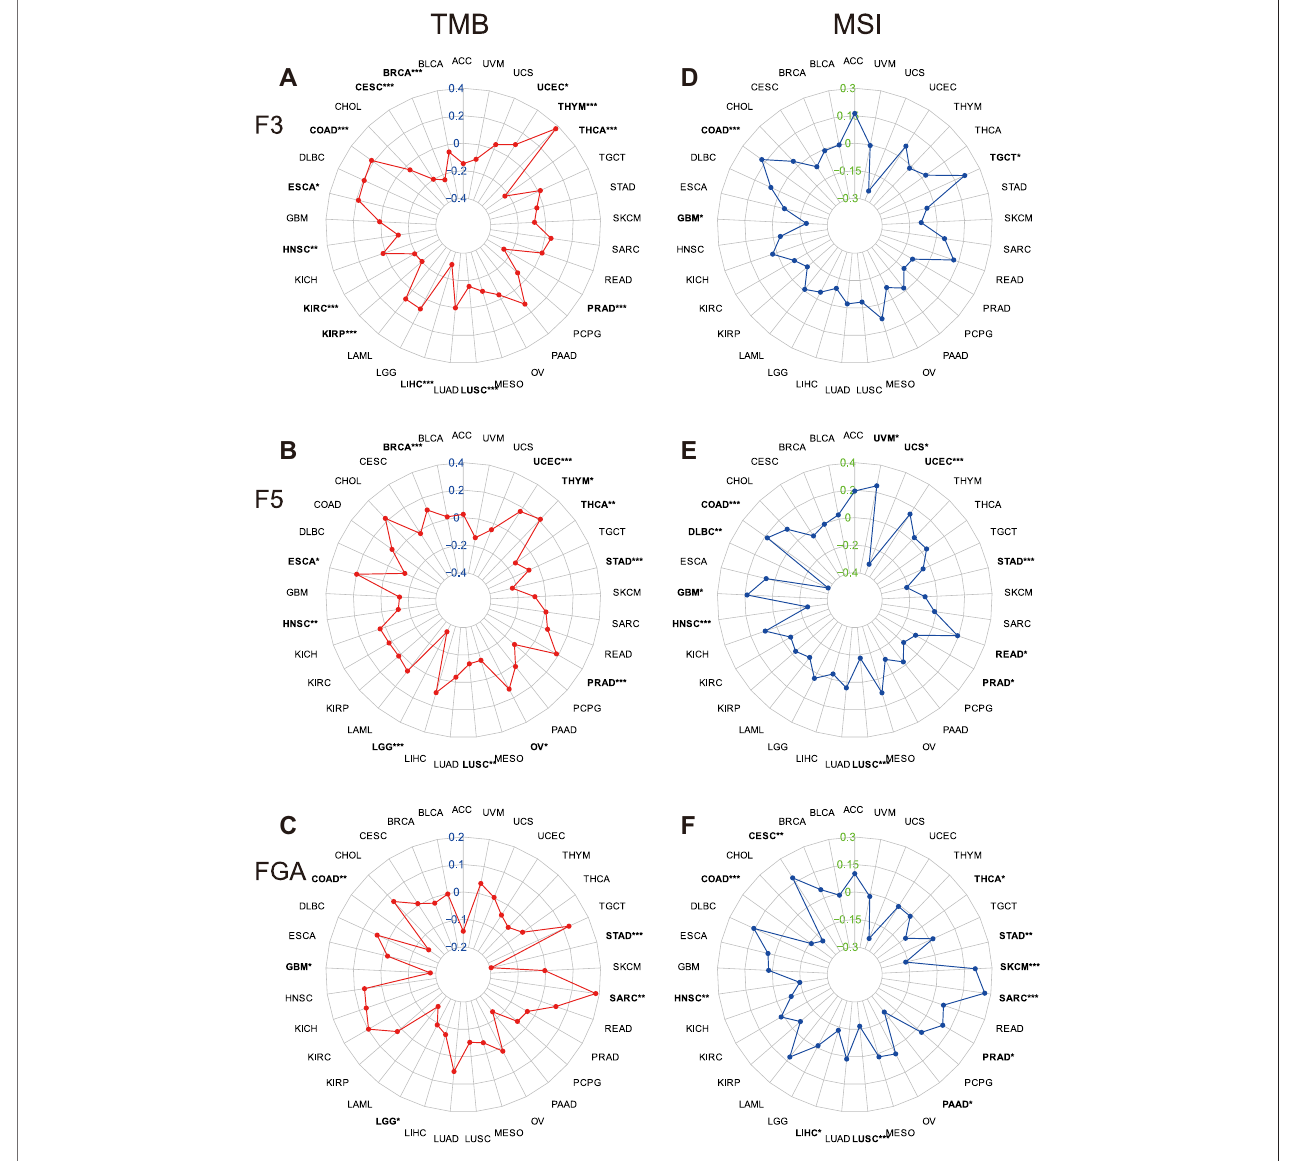
FIGURE 1 | Correlation between the expression of D-dimer-related genes and the tumor mutation burden (TMB) and microsatellite instability (MSI) in TCGA cancers. (A – C) Correlation between the expression of D-dimer-related genes and TMB in 33 types of cancers. (D – F) Correlation between the expression of D-dimer- related genes and MSI in 33 types of cancers. * indicates p < 0.05, ** indicates p < 0.01, and *** indicates p < 0.001, every tumors with a signi fi cant p value was highlighted with a bold